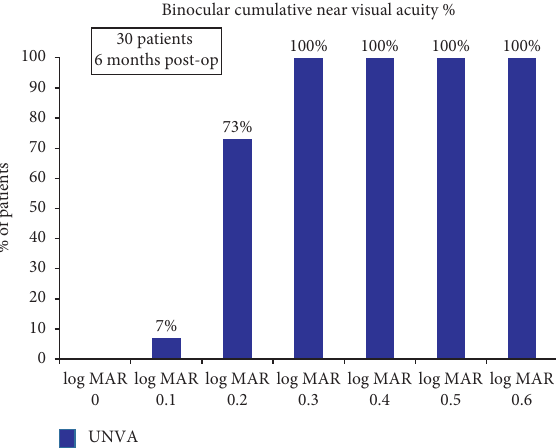
Figure 2: Cumulative histogram for binocular UNVA at 6 months post-op. Table 2: Visual acuity outcomes and reading performance at 6 months